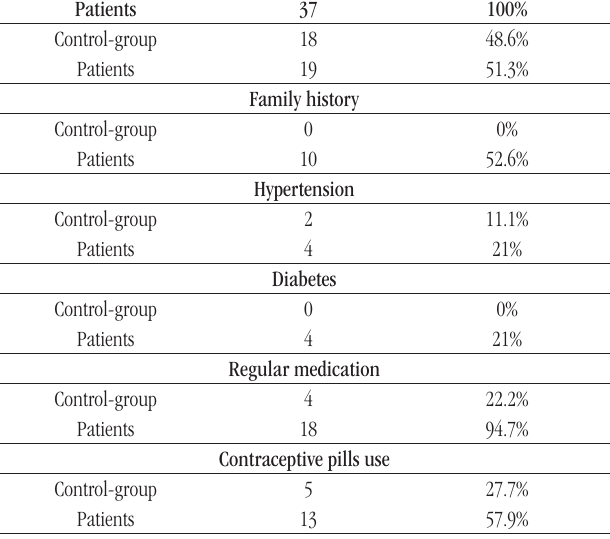
taBLE 1 − Clinical and personal characteristics of the participants